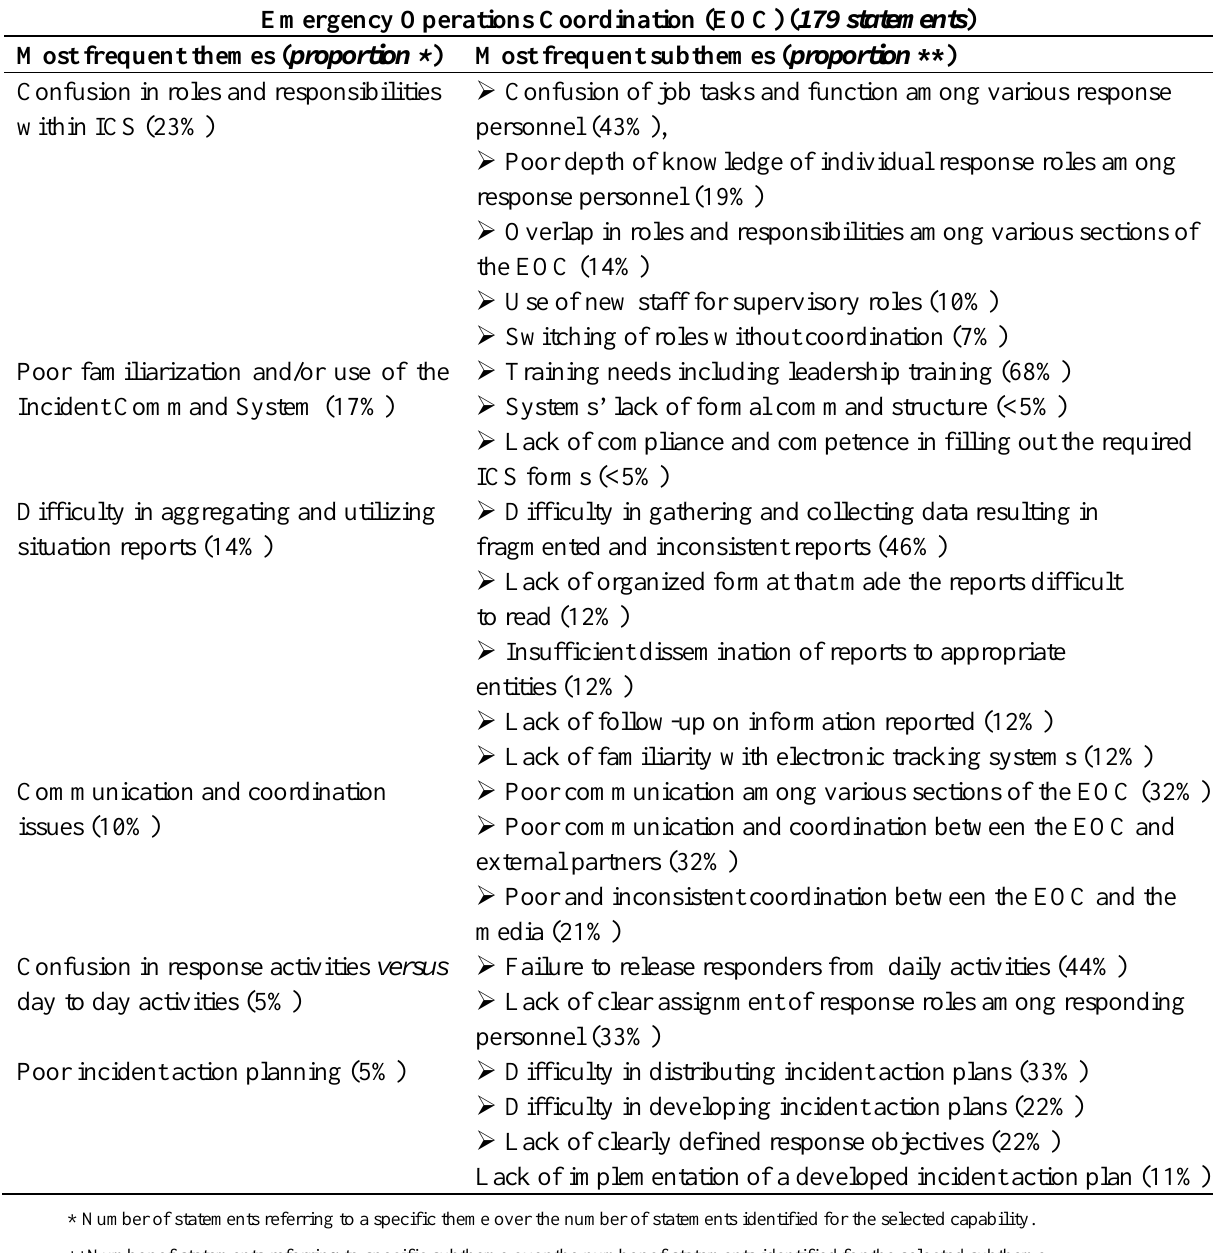
Table 3. Analysis of themes and sub-themes for the capability of emergency operation coordination